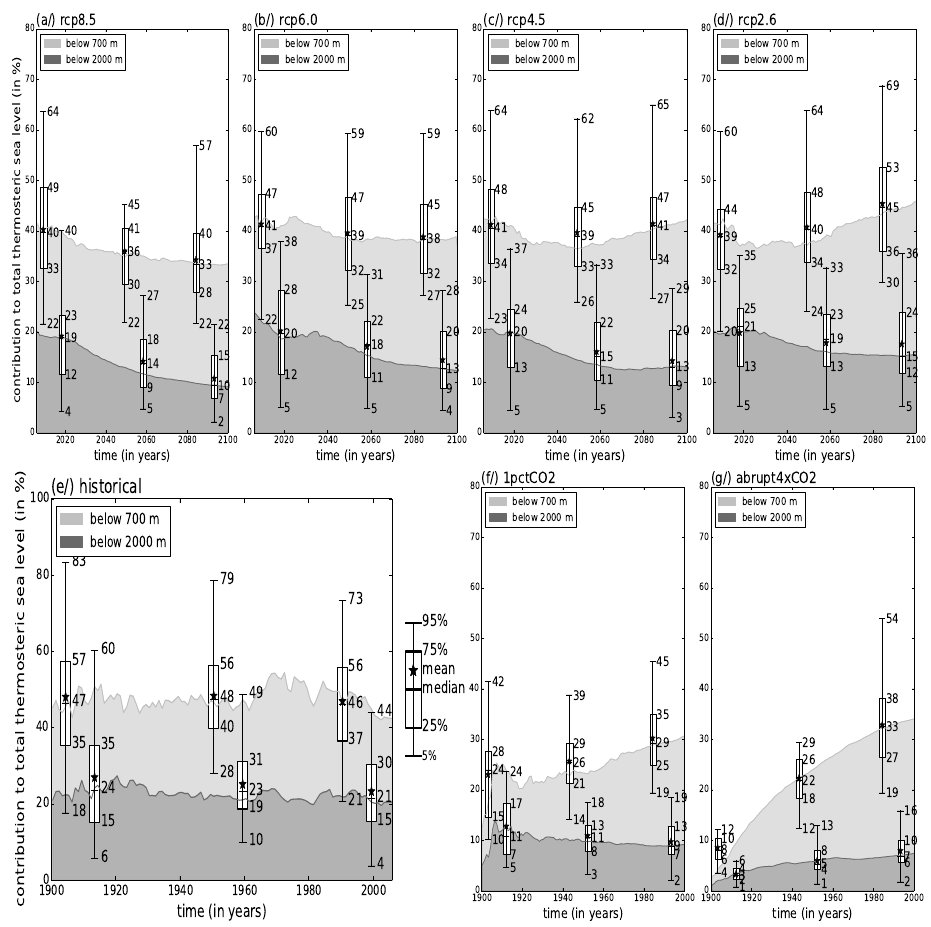
Figure 3. Model median percentage contribution to global mean thSLR for the entire water column from depths below 700m (light grey) and below 2000m (dark grey) for the historical scenario, for projections for the four RCP scenarios and the two idealized CO 2 scenarios derived from Eq. (2). Whisker plots quantify the temporal average distribution of the contribution to thSLR of the first 20years, the entire time series and the last 20 years, respectively: 2006–2025/2006–2100/2081–2100 for RCPs (a – d) ; 1901–1920/1900–2005/1981–2005 for the historical scenario (e) ; and 1–20/1–100/81–100 for the 1pctCO2 and abrupt4xCO scenarios (f , g) . Bars and whiskers represent the 25–75 and 5–95% uncertainties of the median, respectively; the central mark of the bar indicates the model median, the asterisk the model